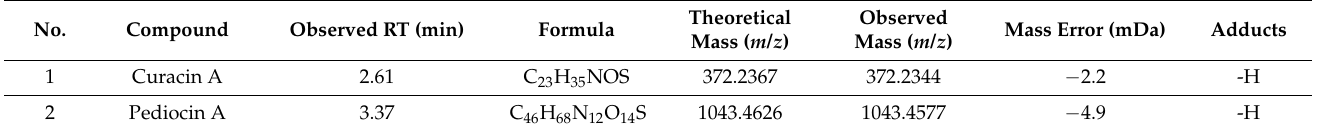
Table 5. Identification of antimicrobial compounds from P. inopinatus